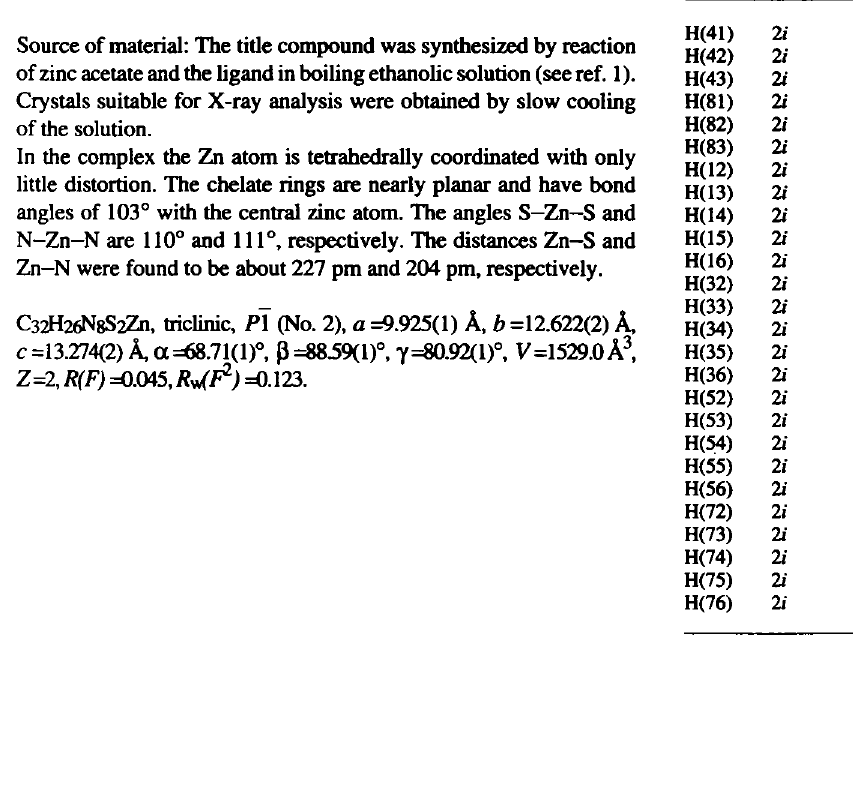
Table 2. Final atomic coordinates and displacement parameters (in Â 2